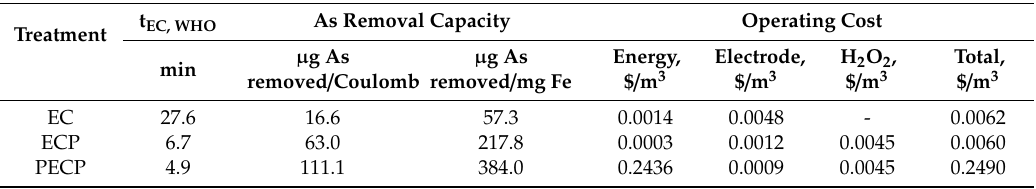
Table 1. Treatment time, arsenic removal capacity, and operating cost required for electrocoagulation (EC), electrochemical peroxidation (ECP), and photo-assisted electrochemical peroxidation (PECP) processes to reach maximum contaminant level (MCL).